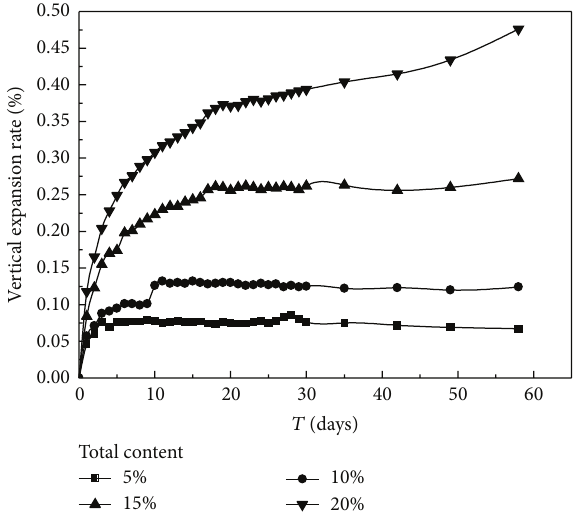
Figure 5: Effect of the total content on expansion rate ( 𝐾 =